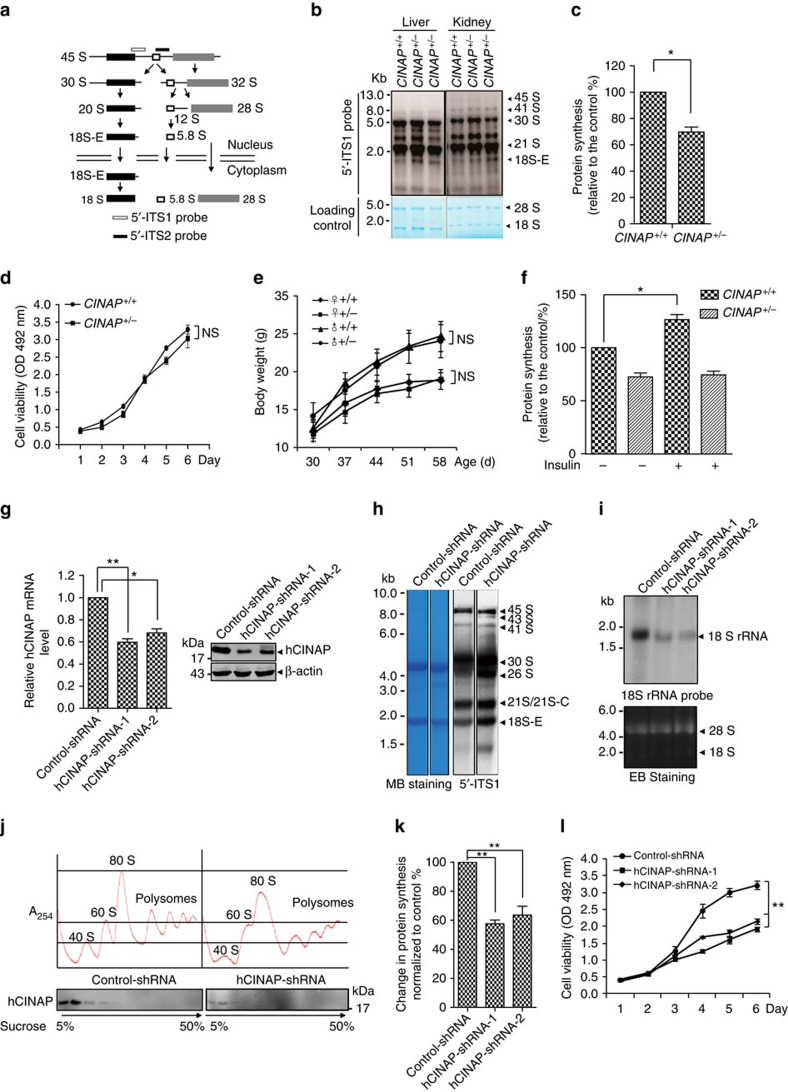
CINAP deletion inhibits 18S rRNA processing and blocks rapid cell growth.(a) Schematic diagram of rRNA processing in eukaryotes. The 5′-ITS1 and 5′-ITS2 probes used in the northern blot assay are indicated. (b) Total RNA of organs from CINAP+/+ and CINAP+/− mice (female, 6 week of age, 3 mice used, randomly selected) was extracted and subjected to northern blot analysis with the 5′-ITS1 probe. 28S and 18S rRNA were shown as loading control. Killing of mice was approved by Peking University Laboratory Animal Center. (c) 35S-methionine labelling of CINAP+/+ and CINAP+/− MEF cells. The number of counts was normalized to protein content. *P<0.05 (Student's t-test). (d) Cell proliferation rate of CINAP+/+ and CINAP+/− MEF cells was measured by MTT assays. (NS, no significance, two-way analysis of variance (ANOVA)). (e) The body weight of female and male mice (10 mice per group, randomly assigned) was recorded weekly from 30 to 60 days after birth. Results are presented as mean±s.d. (no significance, two-way ANOVA). (f) 35S-methonione labelling in MEF cells stimulated with 100 nM insulin. The methionine incorporation level of wild-type MEF cells without insulin stimulation was considered as 100%. *P<0.05 (Student's t-test). (g) hCINAP knockdown efficiency was assessed by quantitative reverse transcriptase–PCR and western blotting. *P<0.05 and **P<0.01 (Student's t-test). (h) Northern blot analysis with the 5′-ITS1 probe was performed to detect the accumulation of 18S rRNA precursors with hCINAP depletion. 28S and 18S rRNA were shown as the loading control. (i) 18S rRNA production was detected by northern blotting using 18S rRNA probe with hCINAP reduction. (j) Ribosome profiling was performed with MCF7 cells expressing control-shRNA or hCINAP-shRNA. Formation of 40S subunit was monitored by measuring the absorbance at 254 nm. Presence of hCINAP in each fraction was detected by western blot using anti-hCINAP antibody. (k) HeLa cells harbouring control-shRNA or hCINAP-shRNA were incubated with 1 μCi per ml 35S-Methionine and the incorporation of 35S-methonione was detected. **P<0.01 (Student's t-test). (l) Cell proliferation assay was performed with HCT116 cells expressing control-shRNA or hCINAP-shRNA. Results (mean±s.d) were analysed by two-way ANOVA.